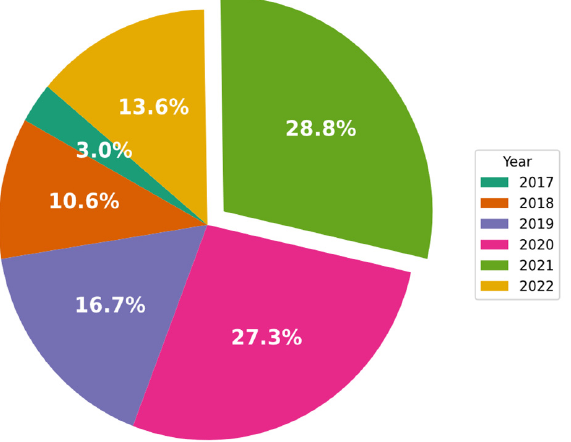
Figure 4. Percentages of CNN-IDS papers published each year.